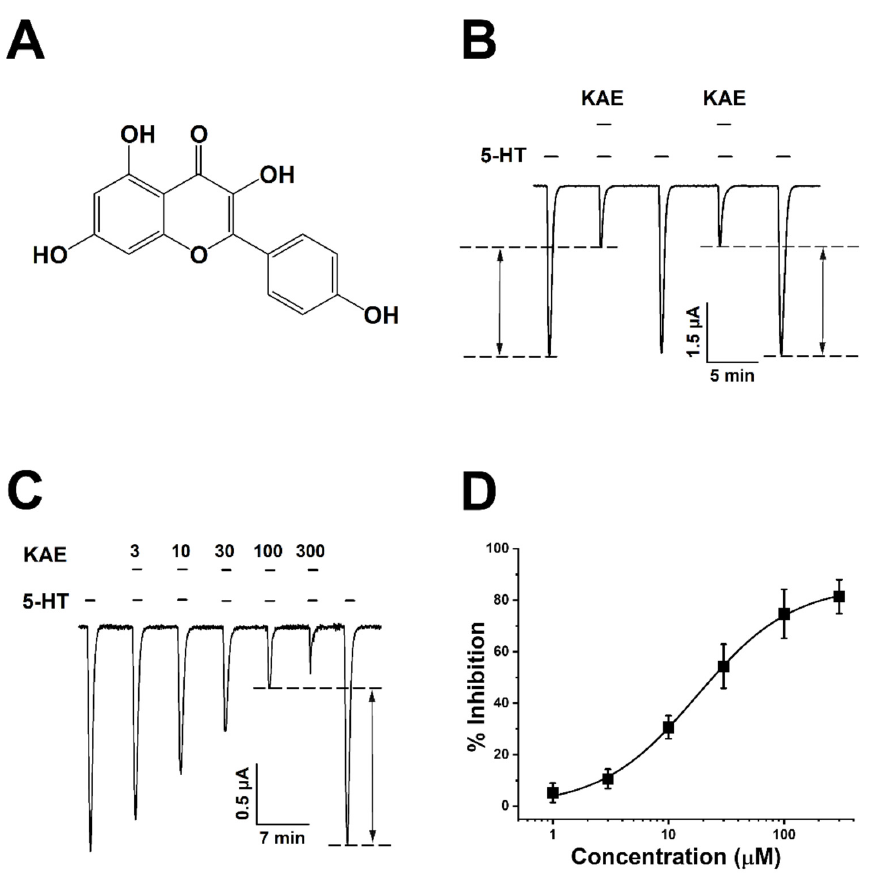
Figure 1. Chemical structure of Kaempferol (KAE) and activation manner confirmed by application to Xenopus oocytes expressing human 5-HT 3A receptor. ( A ) Structure of KAE. ( B – D ) Confirmation of KAE’s inhibition on I 5-HT using a two-electrode voltage clamp. ( B ) Confirmation of the inhibitory manner of KAE on I 5-HT . Black bars indicate applied serotonin and KAE. Applied concentration of serotonin and KAE was 100 µ M. The black dot line indicated in the figure represents the inward current changed when KAE was applied with the control ligand (5-HT, 100 µ M) ( n = 6–8 oocytes from four different frogs). ( C ) Confirmation of concentration-dependent inhibitory manner of KAE on I 5-HT . Black bar indicates the application serotonin and KAE. The applied concentration of serotonin was fixed at 100 µ M and the applied concentration of KAE is indicated in the figure (3–300 µ M) ( n = 7–9 oocytes from four different frogs). ( D ) I 5-HT inhibitory current according to the concentration-specific application of KAE is shown as a normalized curve. The inhibition percentage for human 5-HT 3A was fitted to the Hill equation. The x -axis shows the applied concentration of KAE and the y -axis shows the inhibition percentage of KAE on 5-HT 3A . Each point represents the inhibition percentage, error value, and mean ± SEM ( n = 7–9 oocytes from four different frogs) according to statistical analysis. All experiments were carried out at − 80 mV voltage-clamp holding potential and the rate of application of the agent was 2 mL per